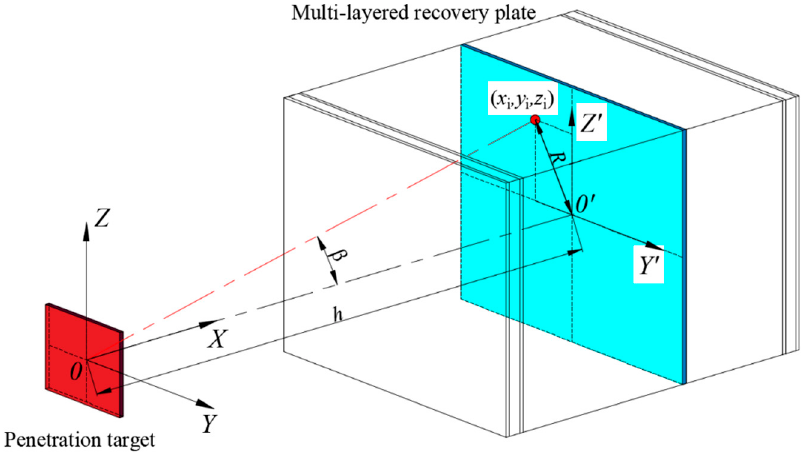
Figure 5. Schematic diagram of three-dimensional coordinates of the striking position of BAD. The distance R i ( R i = 2 y z ) between the fragment position in the recovery plate and the center perforation of residual EFP was taken as the radial scattering distance of the fragment, a factor which reflects the radial penetration ability. Figure 6 shows a diagram of the method for measuring R on the recovery plate. The scattering angle β of the fragment is the angle between the line formed by the fragment position and the origin versus the x axis (Figure 5). The scattering angle of each fragment could be calculated based on R and the distance h between the recovery plate and the back of the steel target: